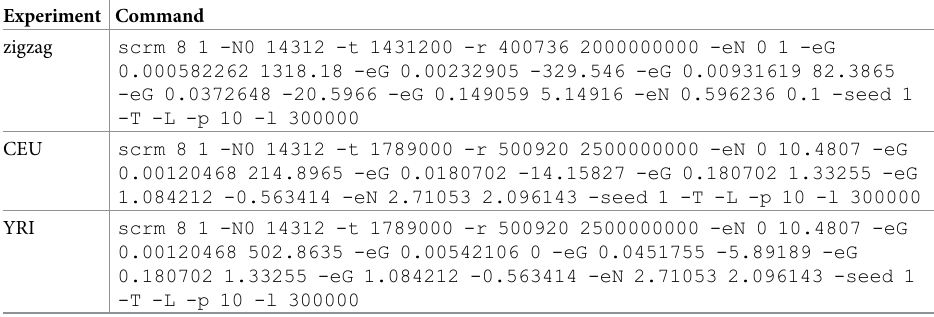
Table 2. Commands to generate simulation